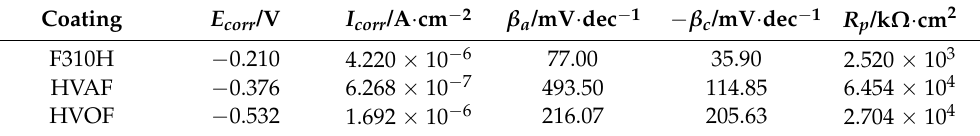
Figure 11. Potentiodynamic polarization curves of HVAF and HVOF coatings in comparison with the F310H substrate in 3.5 wt.% NaCl solution. Table 6. Parameter values of potentiodynamic polarization curves of HVAF and HVOF spray coatings in 3.5 wt.% NaCl solution at room